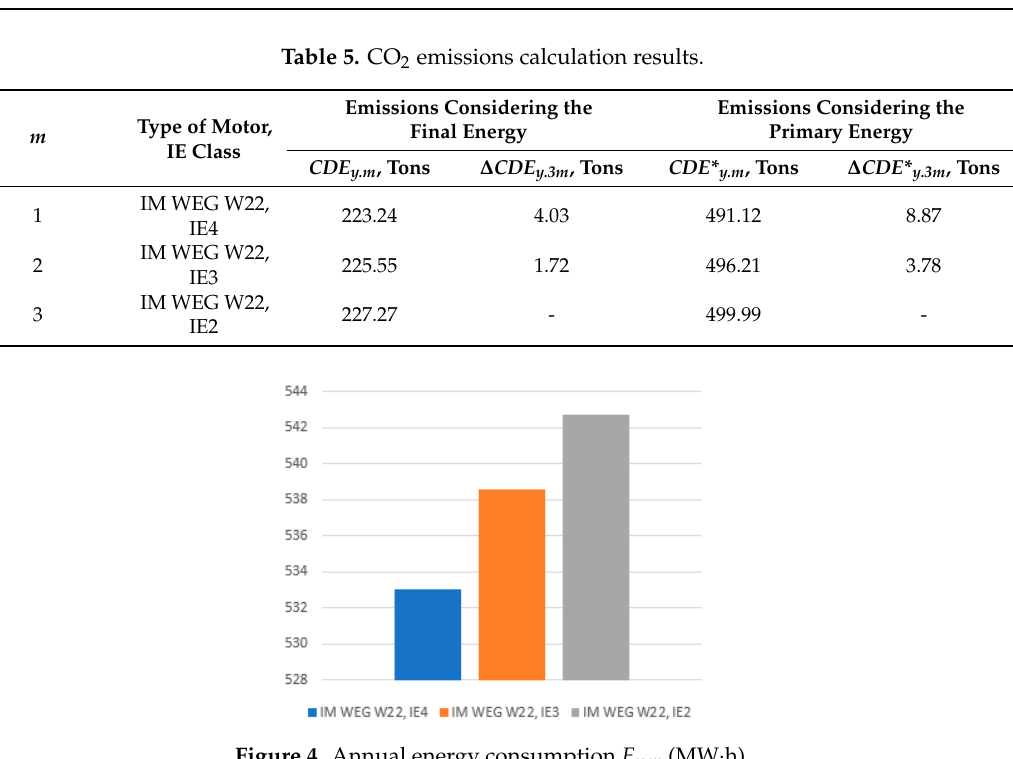
Figure 3. Motors’ efficiency interpolated curves and initial points.